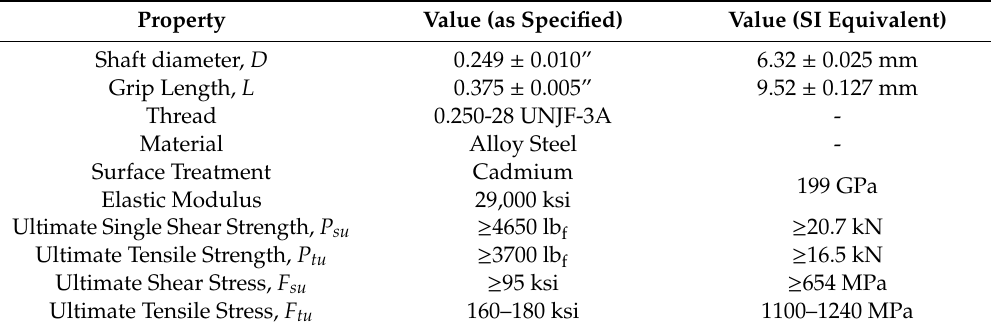
Table 1. Mechanical properties of HL51-8-6 fastener pin [11].